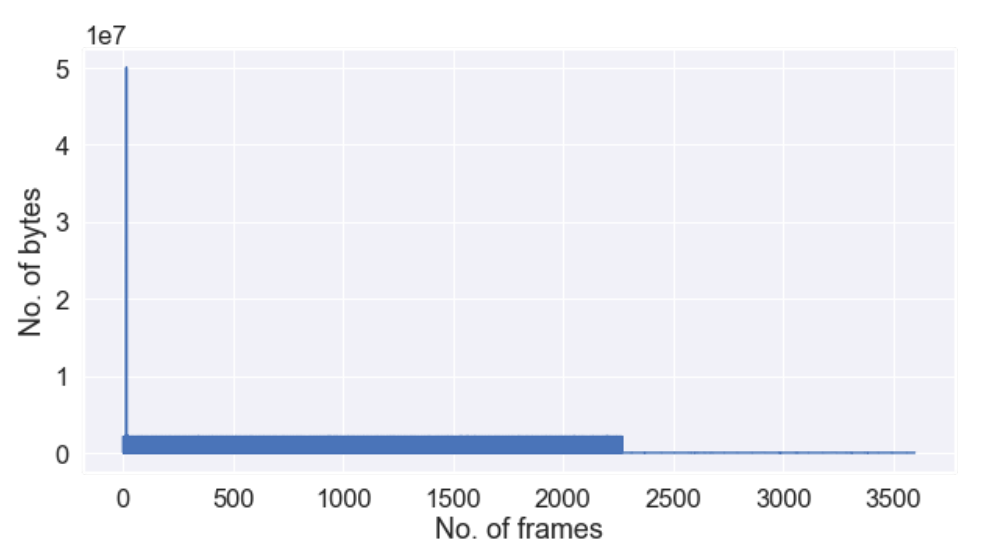
Figure 22b. Disk writes in S2.3.